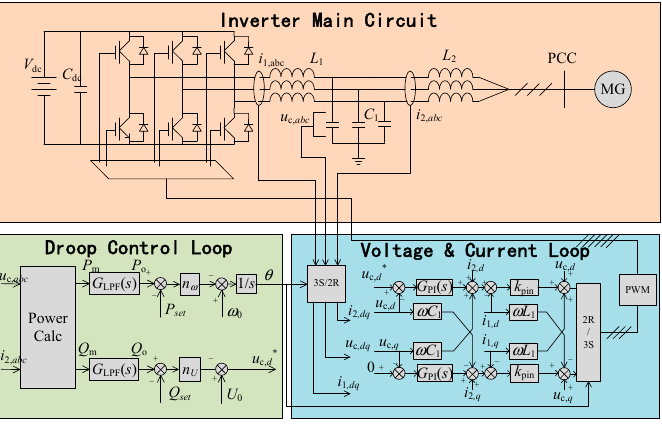
Figure 2. Control block diagram of the droop-control inverter.